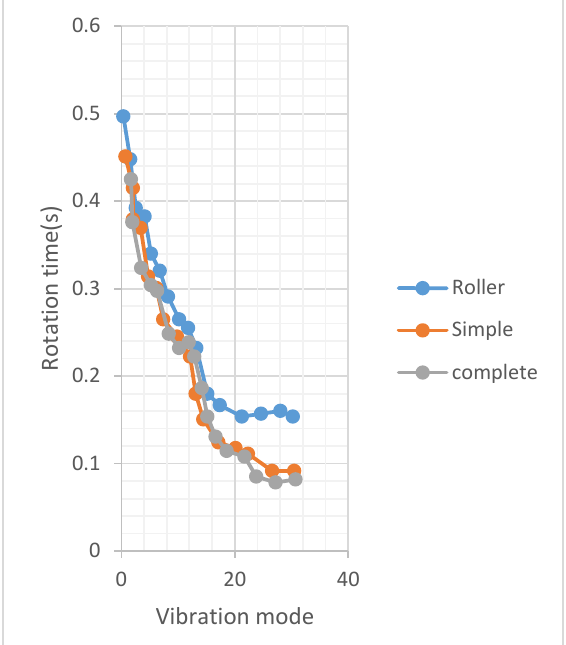
Fig. 7. Six- span bridge with a base height of 6 meters.